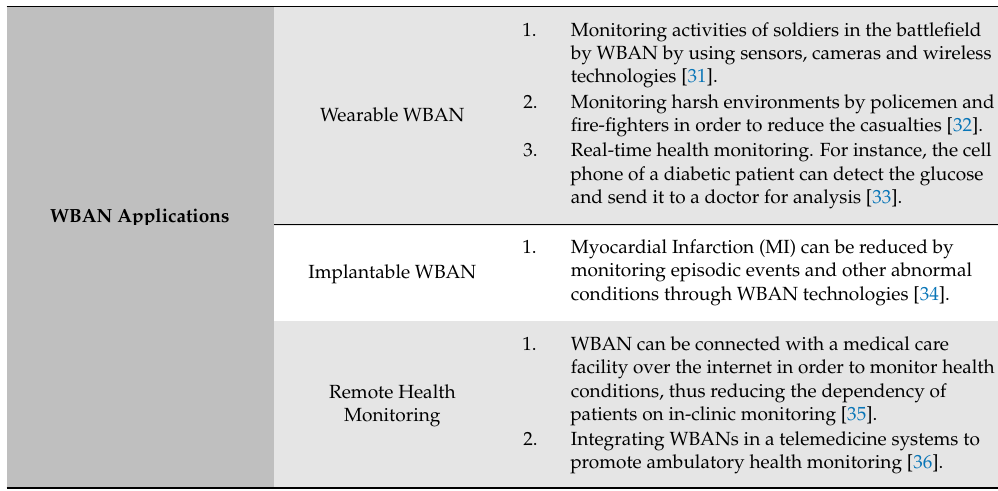
Table 1. Some examples of WBAN applications in the